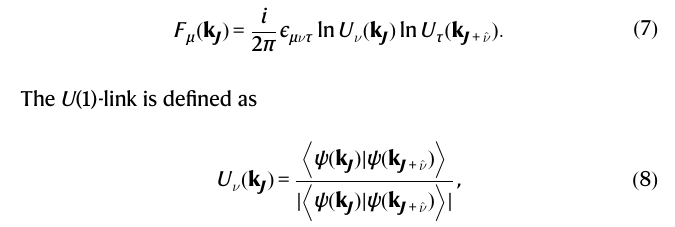
The spin state is readout by counting the spin-dependent number of photons. To enhance collection ef fi ciency, a solid immersion lens with 6.74 μ m diameter is fabricated. The fl uorescence count is about 260 kcps under 0.25 mW laser excitation, with the signal-noise ratio about 100:1. The sequence is repeated 7.5× 10 5 times, collecting about